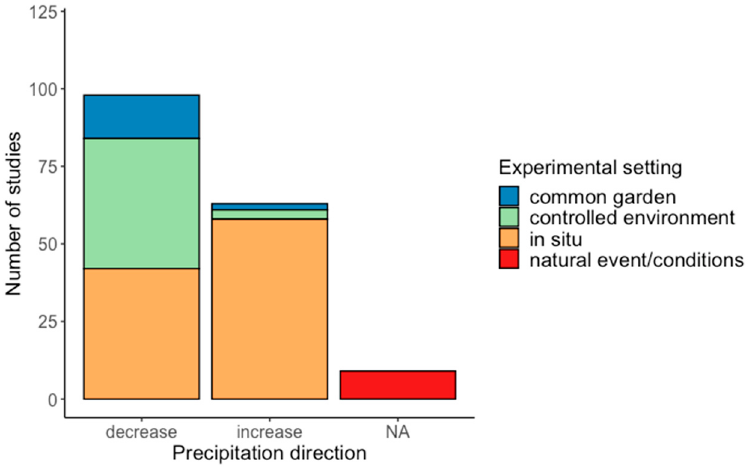
Figure 2. The direction of precipitation treatments included in the systematic review, grouped by experimental setting.